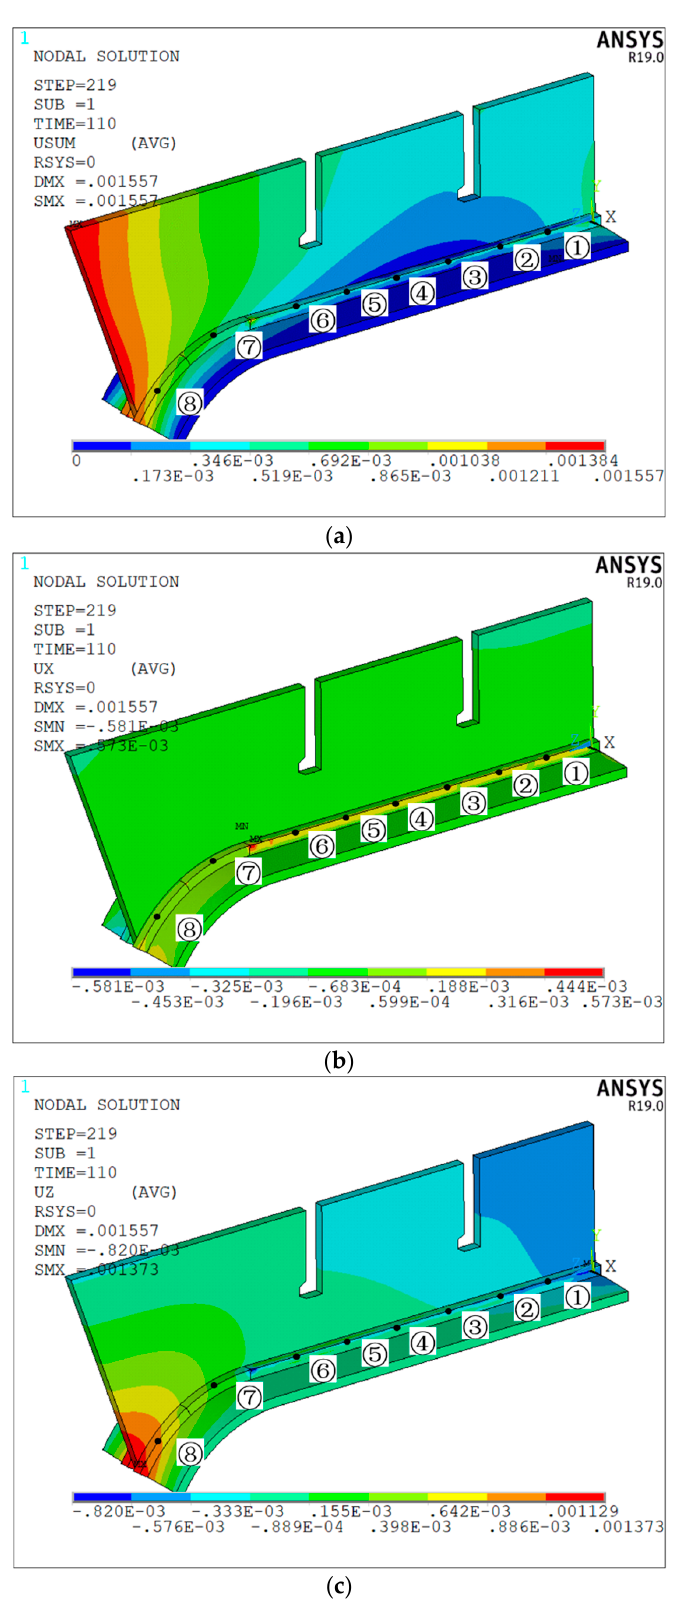
Figure 9. Deformation of welded structure 2 under the welding sequence of “ ④⑤③⑥②①⑦⑧ ”: ( a ) total deformation cloud map; ( b ) deformation cloud map along the x -axis; ( c ) deformation cloud map along the z -axis.